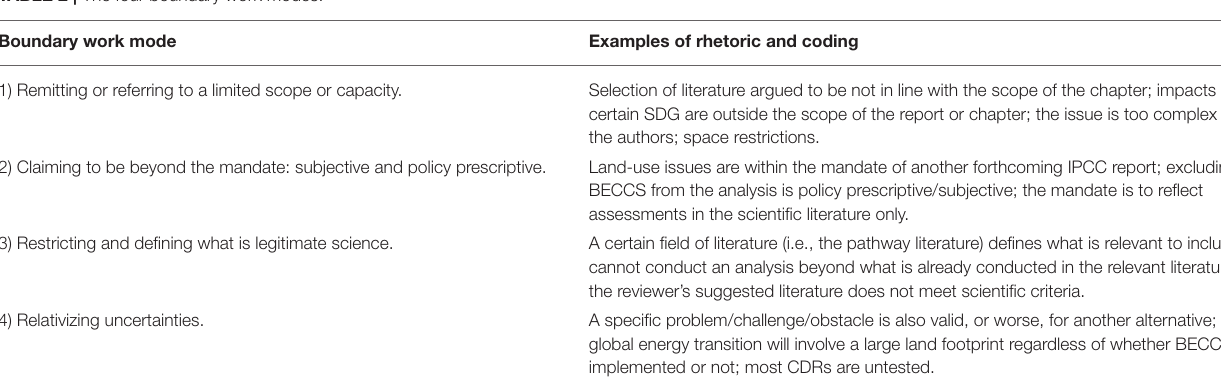
TABLE 2 | The four boundary work